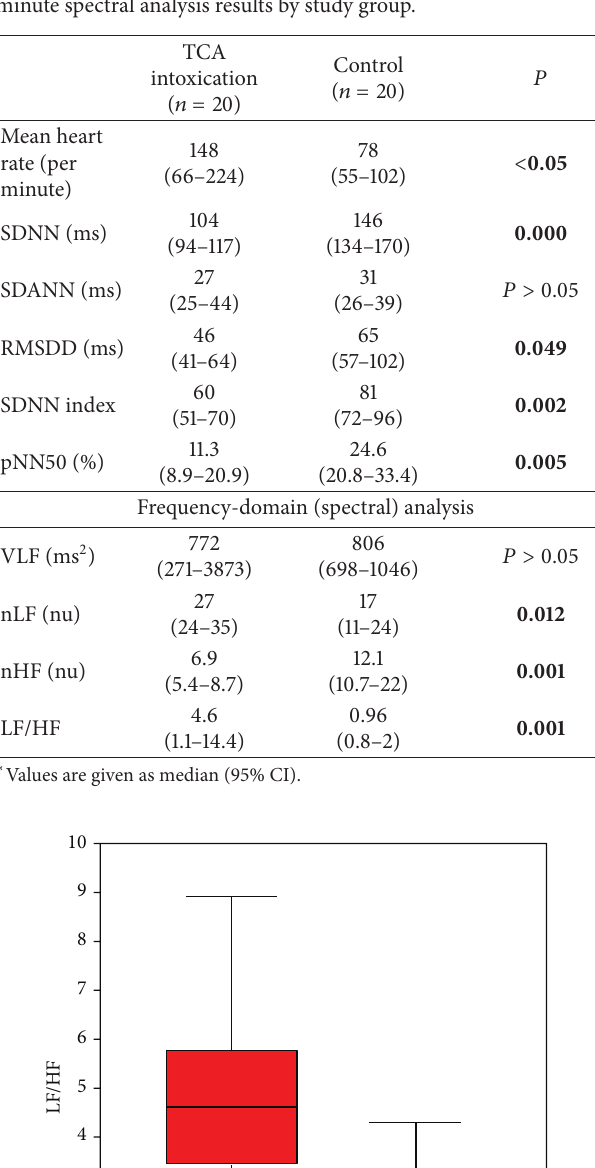
Table 2: Twenty-four-hour time-domain (non-spectral) and 5- minute spectral analysis results by study group.